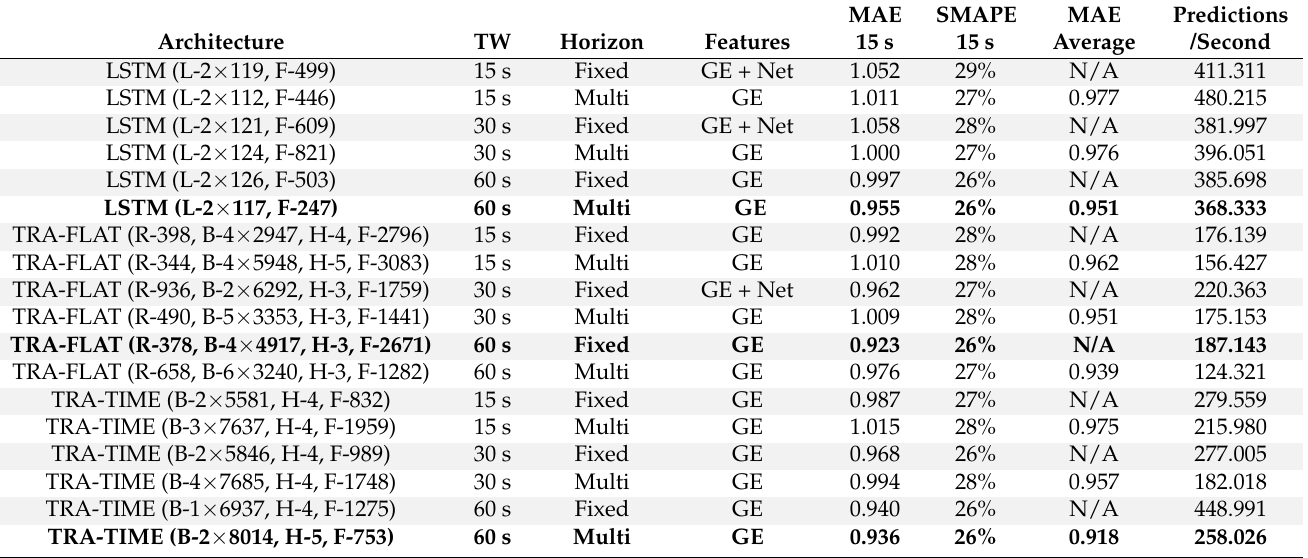
Table 3. The best deep-learning architectures. Deep-learning architectures, the size of the input time window in seconds (TW), the type of model (fixed or multi-horizon), the input features (guide error only or with network), the mean absolute error (MAE), the symmetric mean absolute percentage error (SMAPE) for a 15 s step, the average value of the mean absolute errors for all steps (only for multi-horizon models), and the number of predictions per second are presented. The deep-learning architecture can be either a long short-term memory (LSTM) network defined by the number of layers (L-2) and number of LSTM neurons in each layer ( × 119), followed by the number of output neurons (F-499), or a transformer with flat attention (TRA-FLAT) defined by the number of output neurons in the reduction layer (R-398), the number of attention blocks (B-4) and number of neurons in each block ( × 2947), the number of heads in each block (H-4), and the number of output neurons (F-2796). The transformer with time attention (TRA-TIME) is defined in a similar manner as the TRA-FLAT but without the reduction layer. All the models displayed are suitable for real-time deployment, as they are faster than 10 predictions per second (the data collection speed) and have a SMAPE less than 50% (sufficiently precise for industrial applications). The smallest MAE value for the 15 s step of each architecture is highlighted in bold.